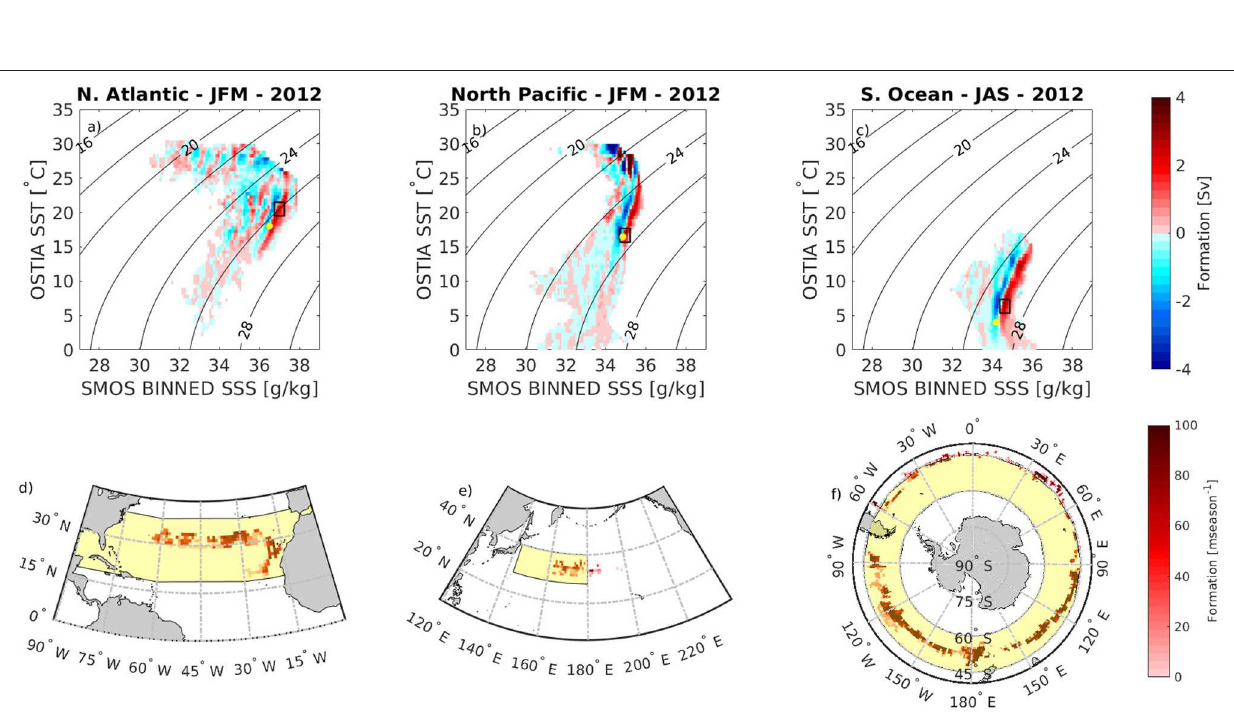
Frontiers in Marine Science | www.frontiersin.org